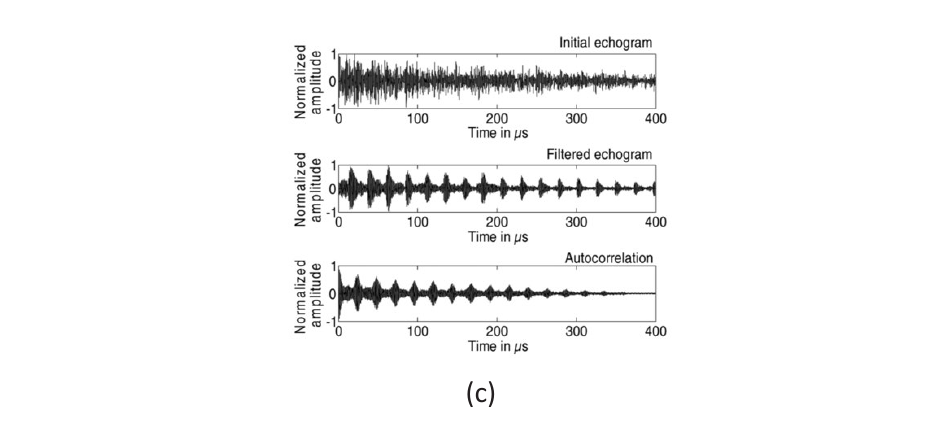
Fig. 1 : REMORA acoustic gas sensor. (a) Schematic representation [1]. (b) Sensor overview [2]. (c) Experimental results including data processing